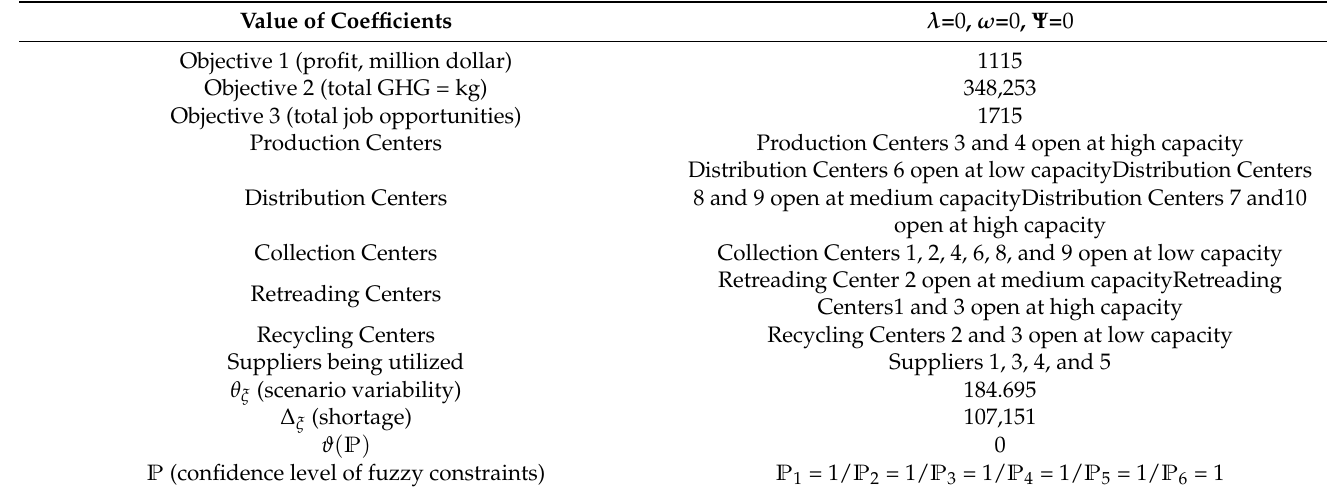
Table 8. Summary of optimum result (demand increased by 20%).